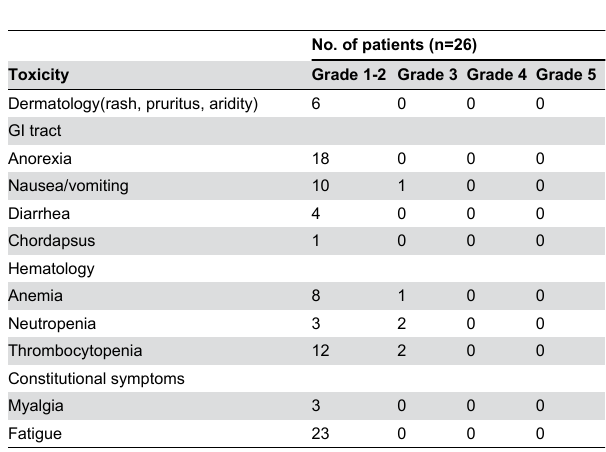
Table 5. Summary of adverse events from cyberknife-